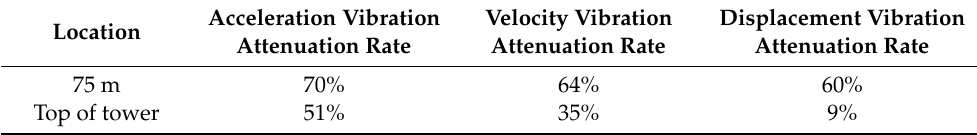
Table 3. Vibration reduction rate at different positions of the